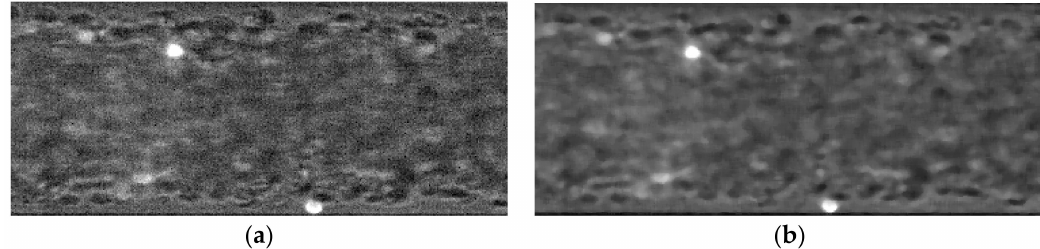
Figure 4. The region of interest ( a ) and the image filtered by using the median function medfilt2 ( b ). In the next stage, the images were subject to a segmentation step using a threshold method. The definition of one or more values of separation is enough to divide the image into one or more regions, that is, differentiate the area of interest (the RBCs) from the not-interest area (background image). The level of threshold is calculated by default, by an iterative method, which means that for each image an adequate level of threshold is calculated. However, users can apply the value that they think to be more appropriate. After thresholding, the objects were defined with the Sobel filter (see Figure 5), which shows only the edge of the objects. The Sobel computes an approximation of the gradient of the image intensity. At each pixel point in the image, the result of the Sobel operator is either the corresponding gradient vector or the norm of this vector [31].